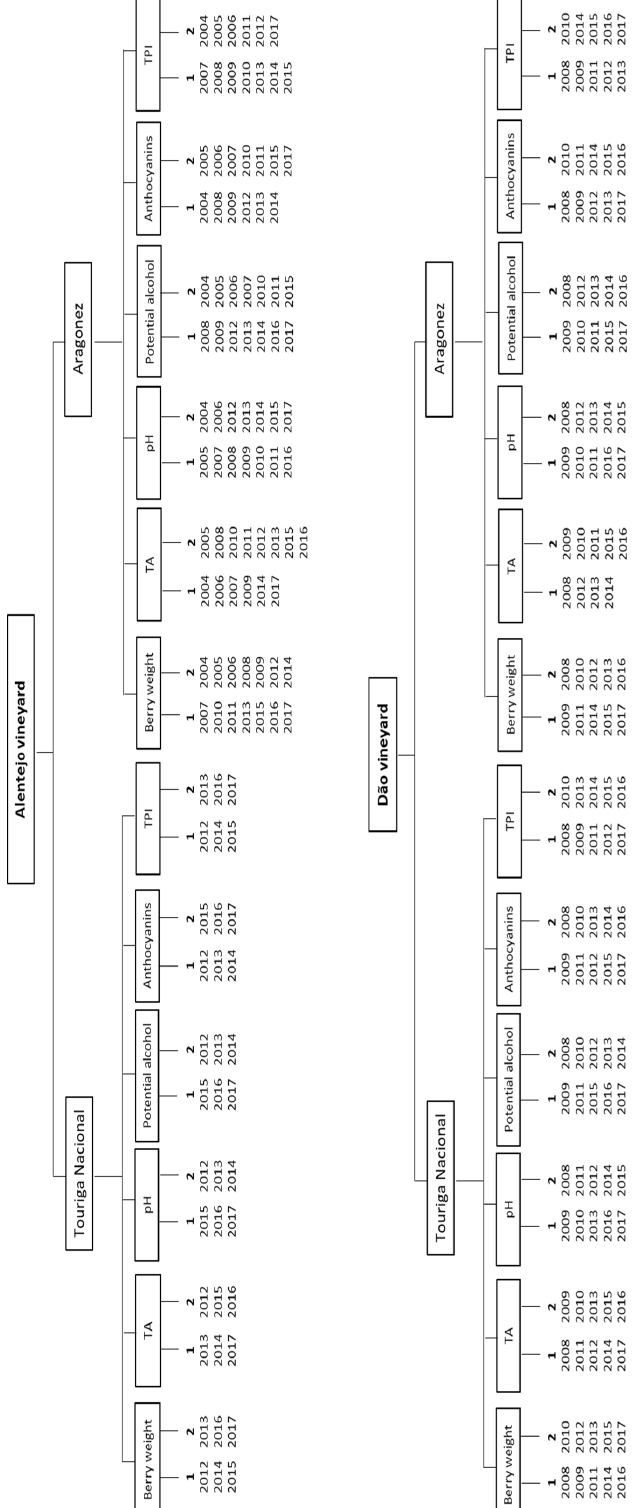
Figure 4. Identification of the years keyed to the di ff erent clusters for each quality parameter and vineyard site (Douro-C, Douro-D, D ã o and